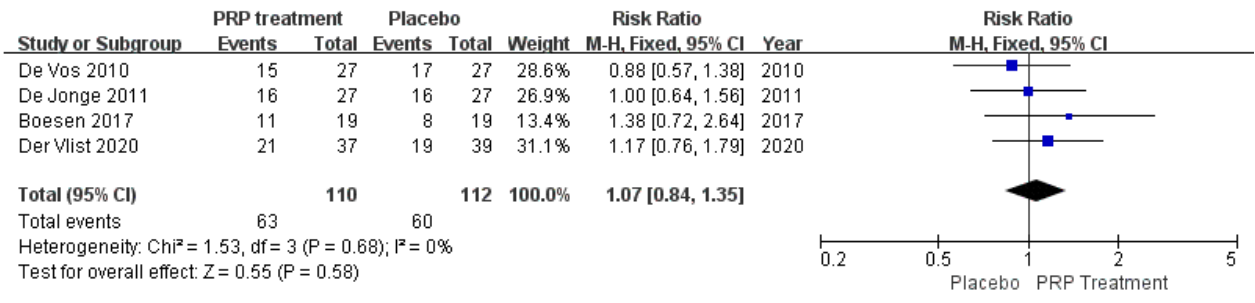
Figure 9. Forest plot of patient return to exercise rate. 4. Discussion PRP has been utilised in the clinic for a long time, and its usefulness in treating AT remains debatable. In this study, an examination of eight high-quality RCTs was con- ducted, and a further conclusion was drawn. AT has several causes, and its specific process is unknown. Most studies have linked AT to overwork, improper exercise, stiff limbs, and weakness-related anatomical abnor- malities. Several mechanisms produce local Achilles tendon irritation. Degenerative changes and Achilles tendon rupture may follow [34]. The Achilles tendon receives insuf- ficient blood supply. It heals more slowly than other connective tissues. Scientists have discovered that growth factors are essential to Achilles tendon recovery and suggest using PRP to treat AT. PRP has been shown to treat AT in several laboratories and limited clinical studies; hence, it is frequently used in clinical practice. [35] PRP relieves pain and improves patient